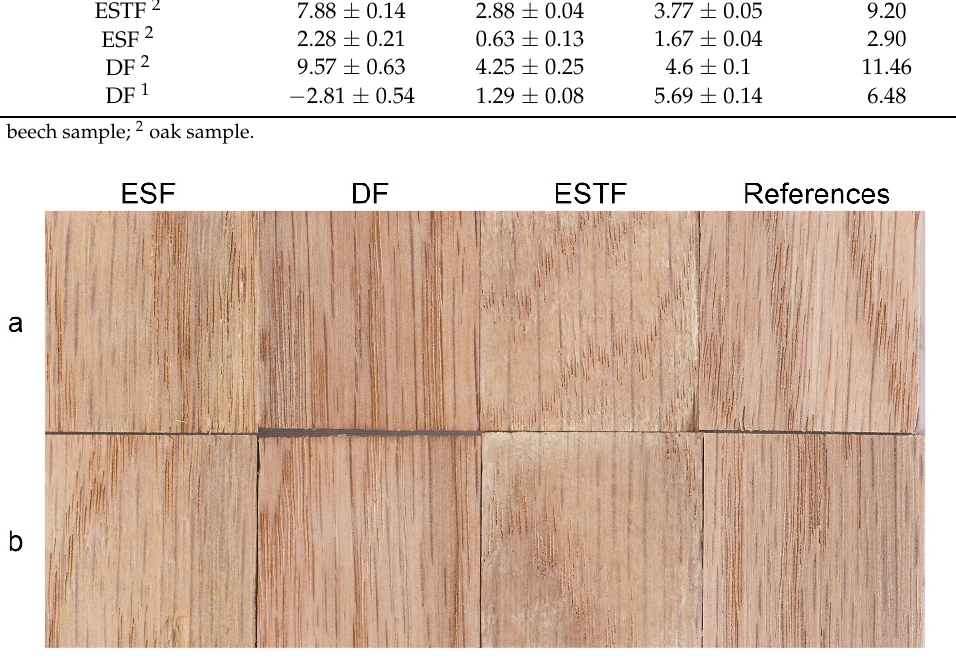
Figure 8. Oak samples after treatment with ESF, DF, or ESTF compared with the wood without coating as reference samples. ( a ) Virgin samples. ( b ) Samples pre-extracted in ethanol.